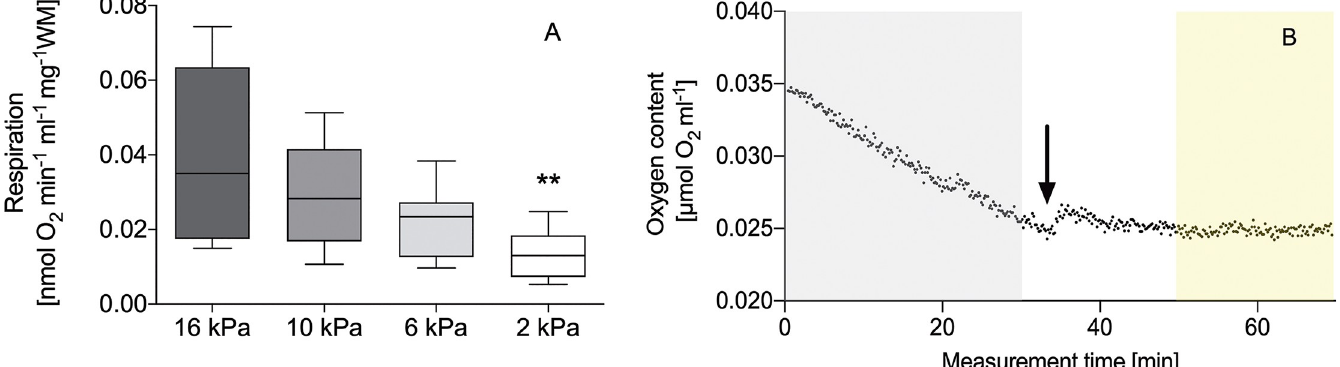
Fig 5. A. Gill-respiration rates of Arctica islandica at four different p O 2 without spermineNONONate; n = 9–12. �� Respiration rates differ significantly between 16 kPa and 2 kPa (One-way ANOVA and Tukey P < 0.005). B: Example of oxygen consumption by live gill tissue at 2 kPa under control conditions (without spermineNONONate, grey background), and under complete NO-induced inhibition of gill respiration (0.00 nmol O 2 min -1 ml -1 mg -1 WM) within 20 min (yellow background) after adding spermineNONONate to the measurement (black arrow). Measurements conducted with an ISO-NOP electrode.